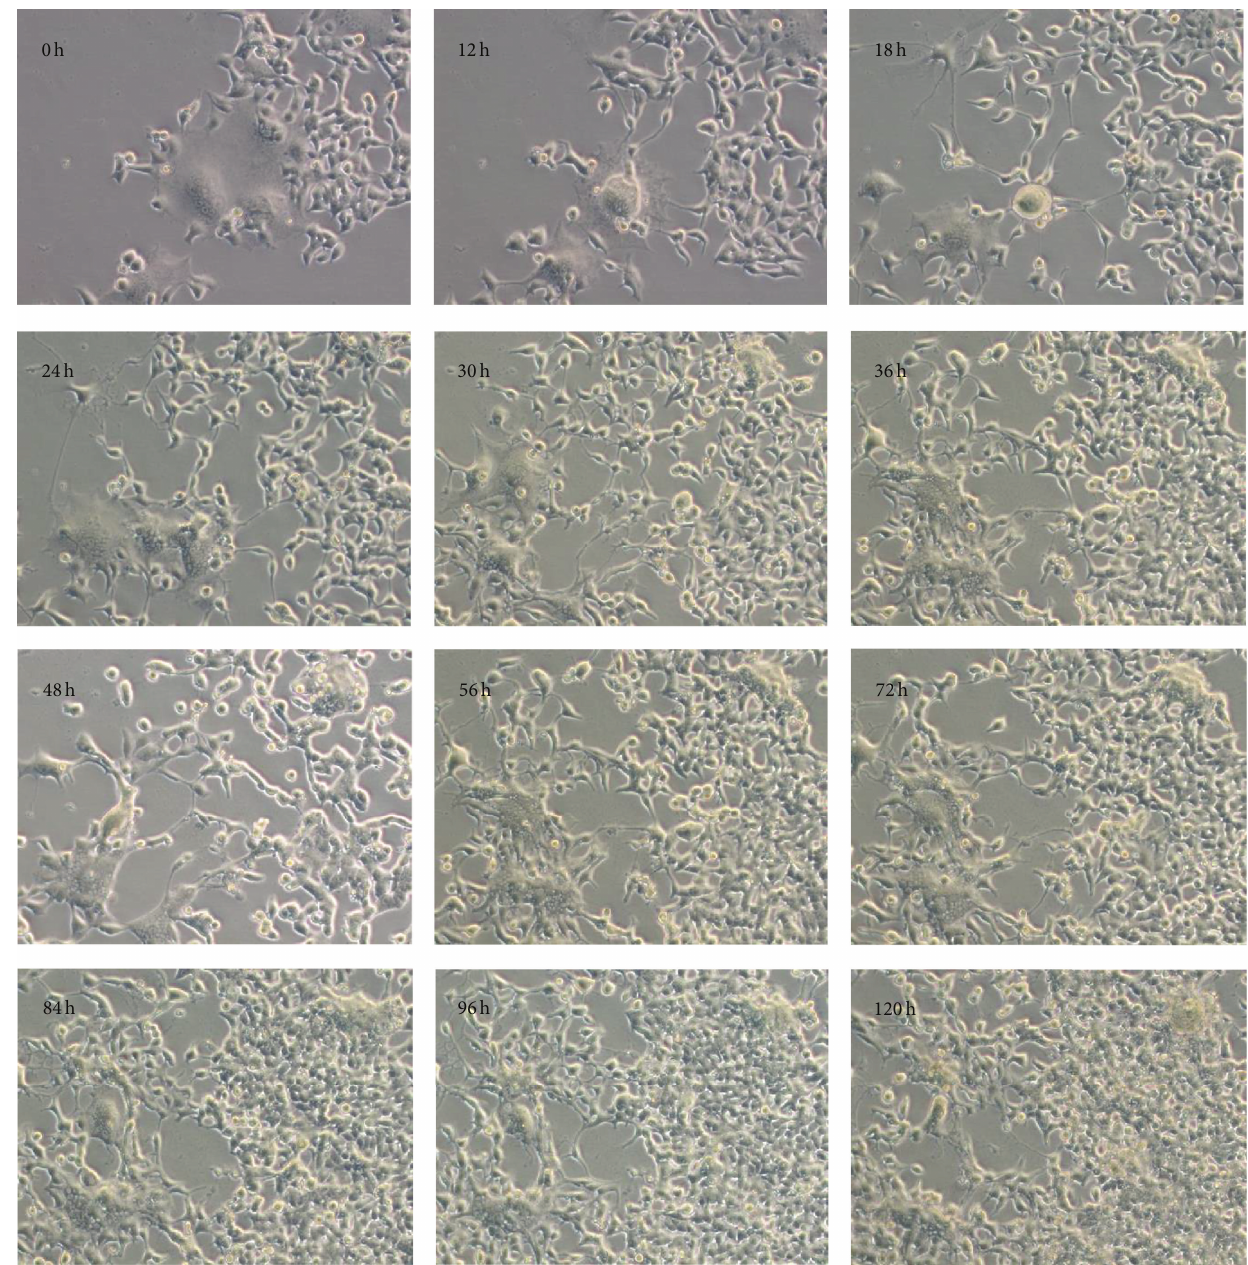
Figure 1: Time-lapse images of HEK 293T and bone marrow mesenchymal stem cell culture [35]. Apoptotic MSCs were surrounded and consumed by the HEK 293T cells during the 120-hour